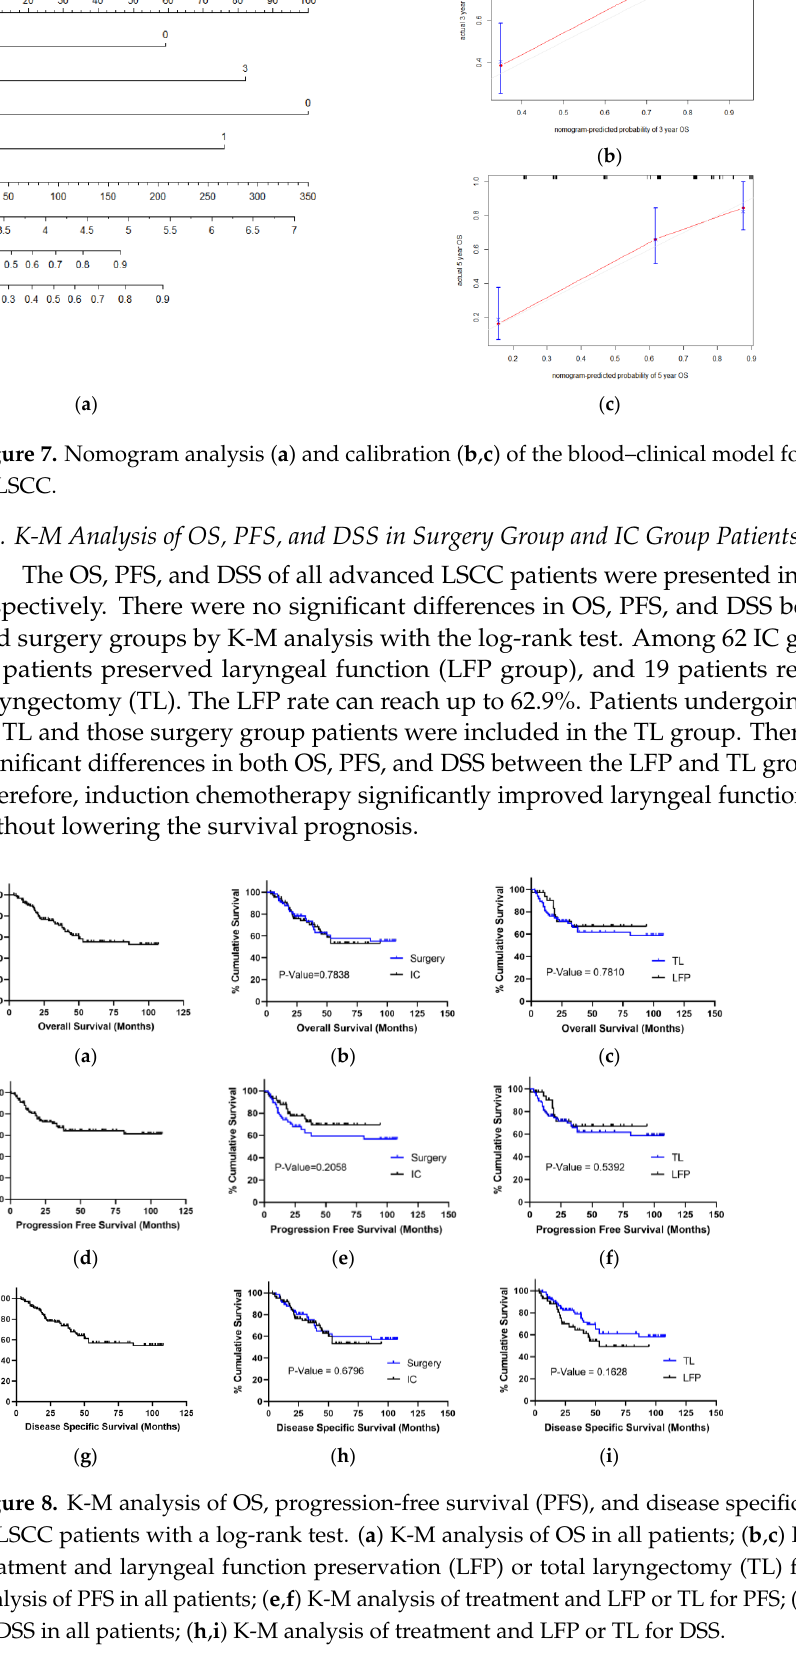
of DSS in all patients; ( h , i ) K-M analysis of treatment and LFP or TL for